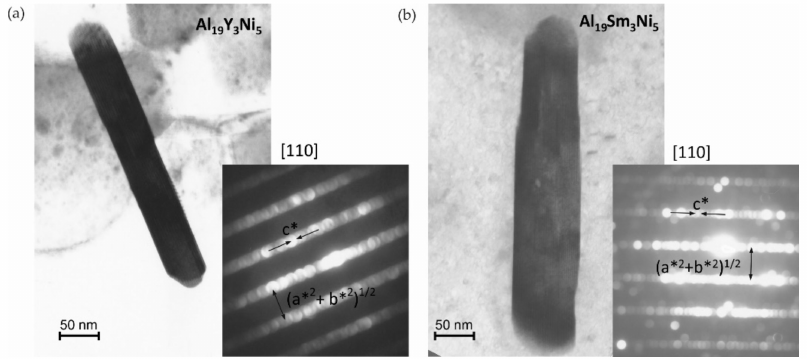
Figure 12. TEM bright field images of Al 19 RE 3 Ni 5 particles in ribbons treated to 450 ◦ C, and microdi ff raction patterns of ( a ) Al 88 -Y 4 -Ni 7 -Cu 1 , and ( b ) Al 88 -Sm 4 -Ni 8 alloys. Reciprocal lattice parameters are used in